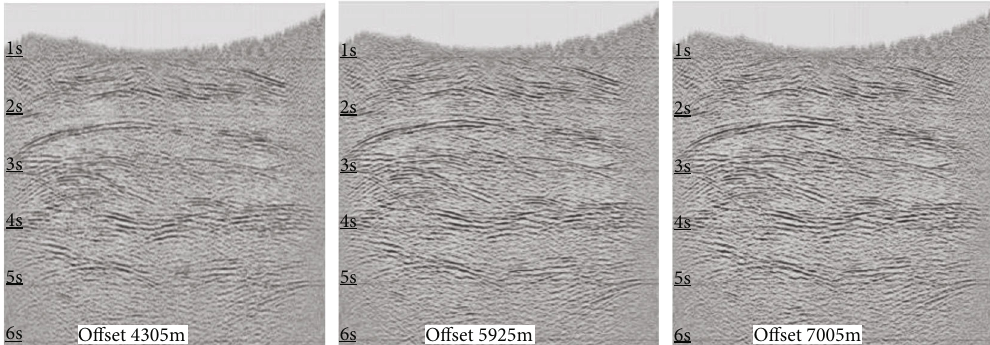
Figure 11: Stack sections with di ff erent maximum o ff sets.